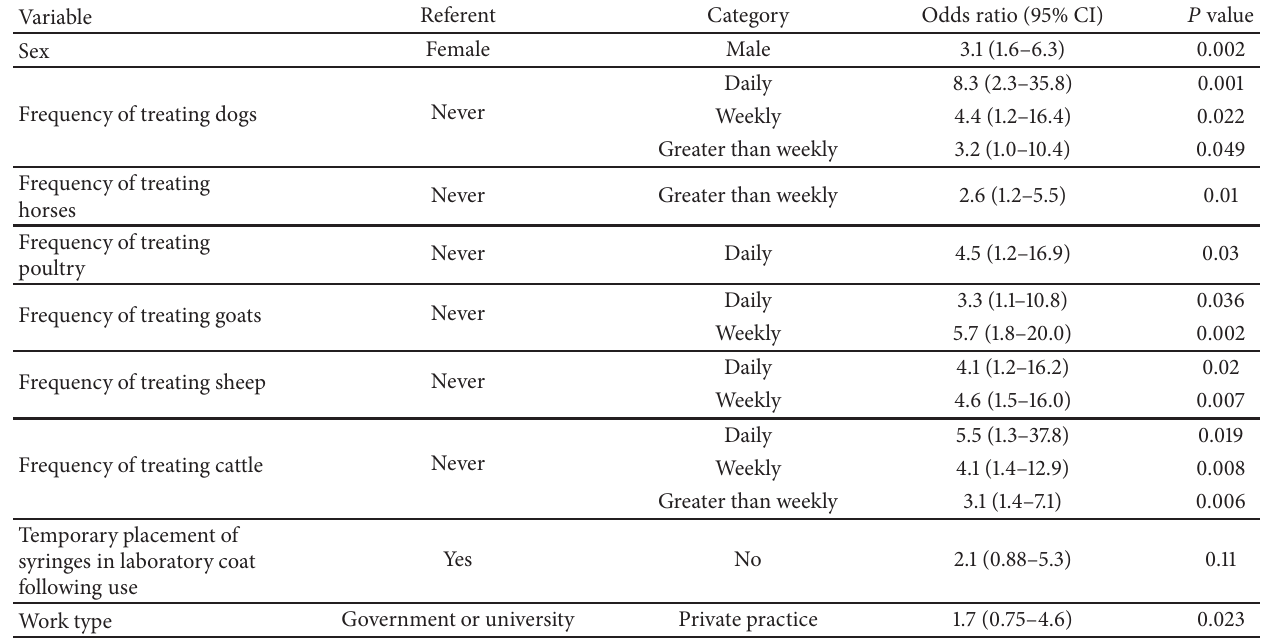
Table 2: Univariable logistic regression results for variables that entered the model based on a 𝑃 ≤ 0.25 .